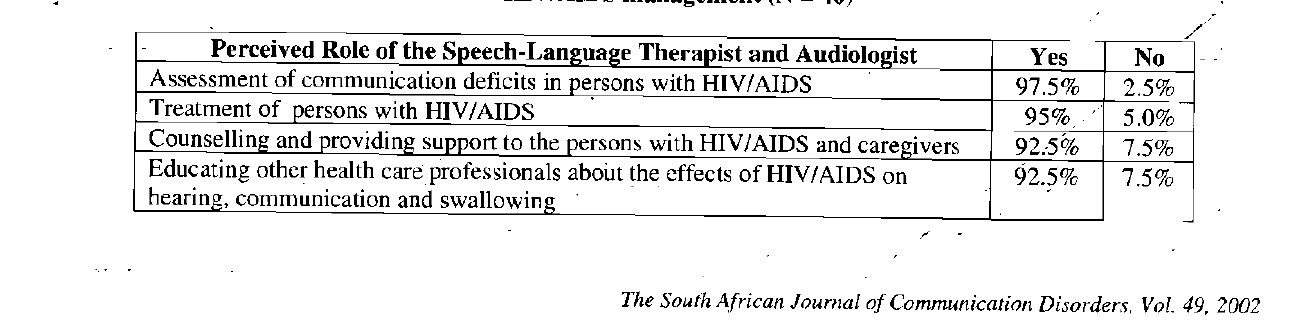
Table 5. Perceived Role of the SLT & A in HIV/AIDS management (N =